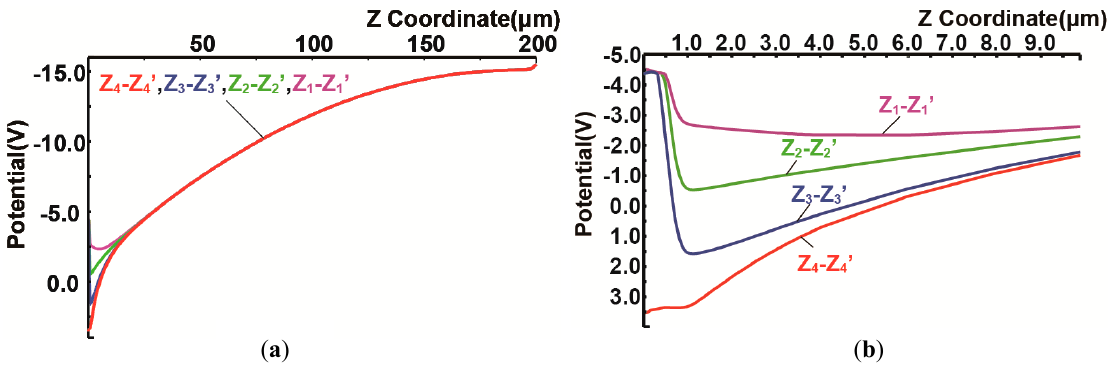
Figure 5. Simulated Vertical Potential Profiles, ( a ) Z = 0 to 200 μ m, ( b ) Z = 0 to 10 μ m.